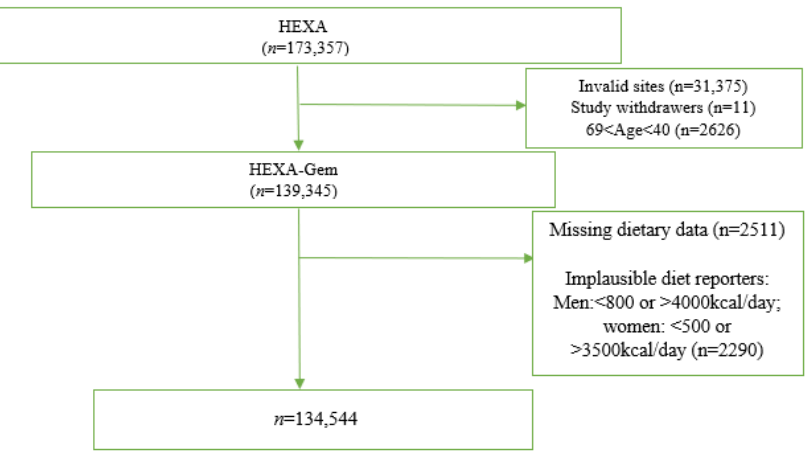
Figure 1. Flow chart showing how study participants were